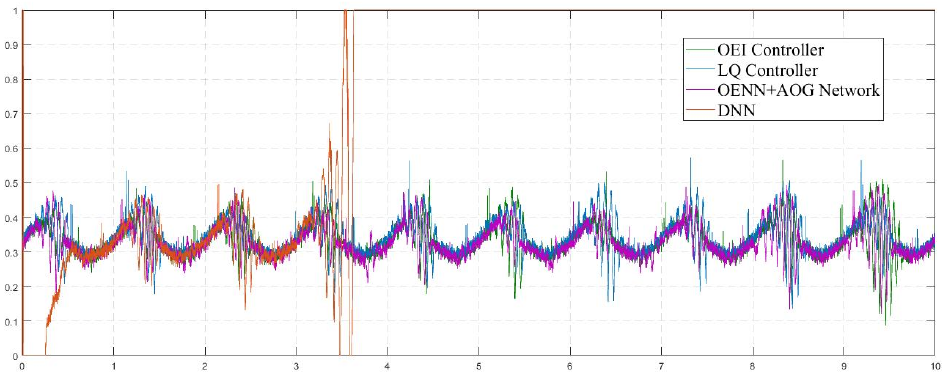
Figure 8. Control